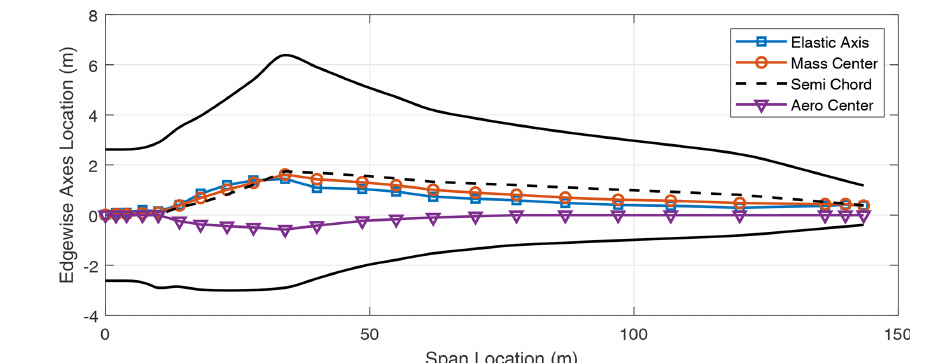
Figure A12. Planform for the SUMR13C turbine blade.